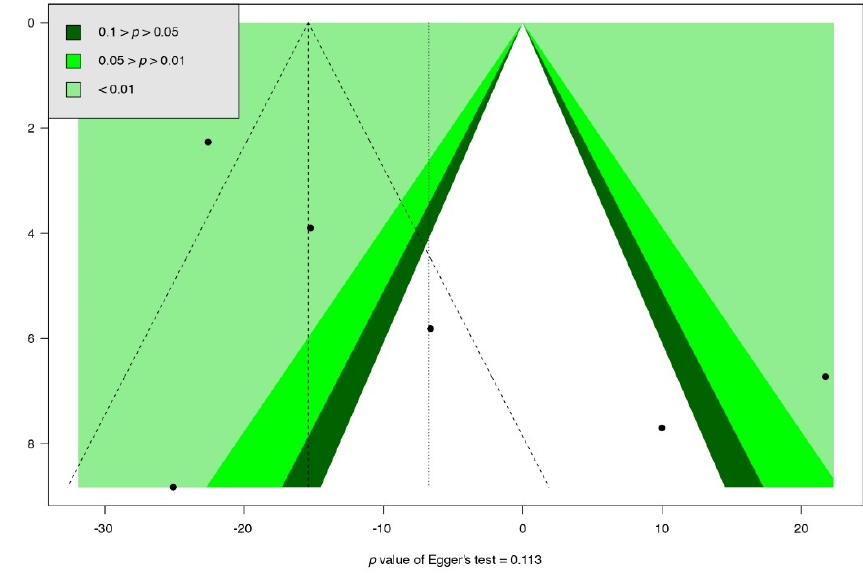
Figure A44. Comparison-adjusted funnel plot in outcome for operative time.